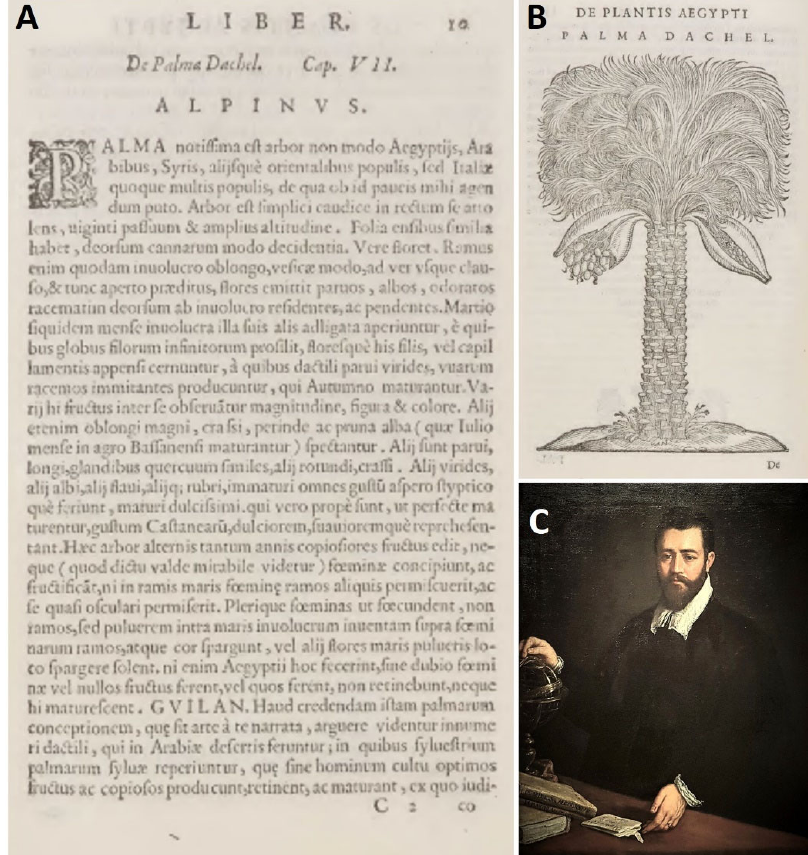
Figure 1. ( A ) A picture of the first page of Chapter VII of “ De Plantis Aegypti liber ”. Reprinted from